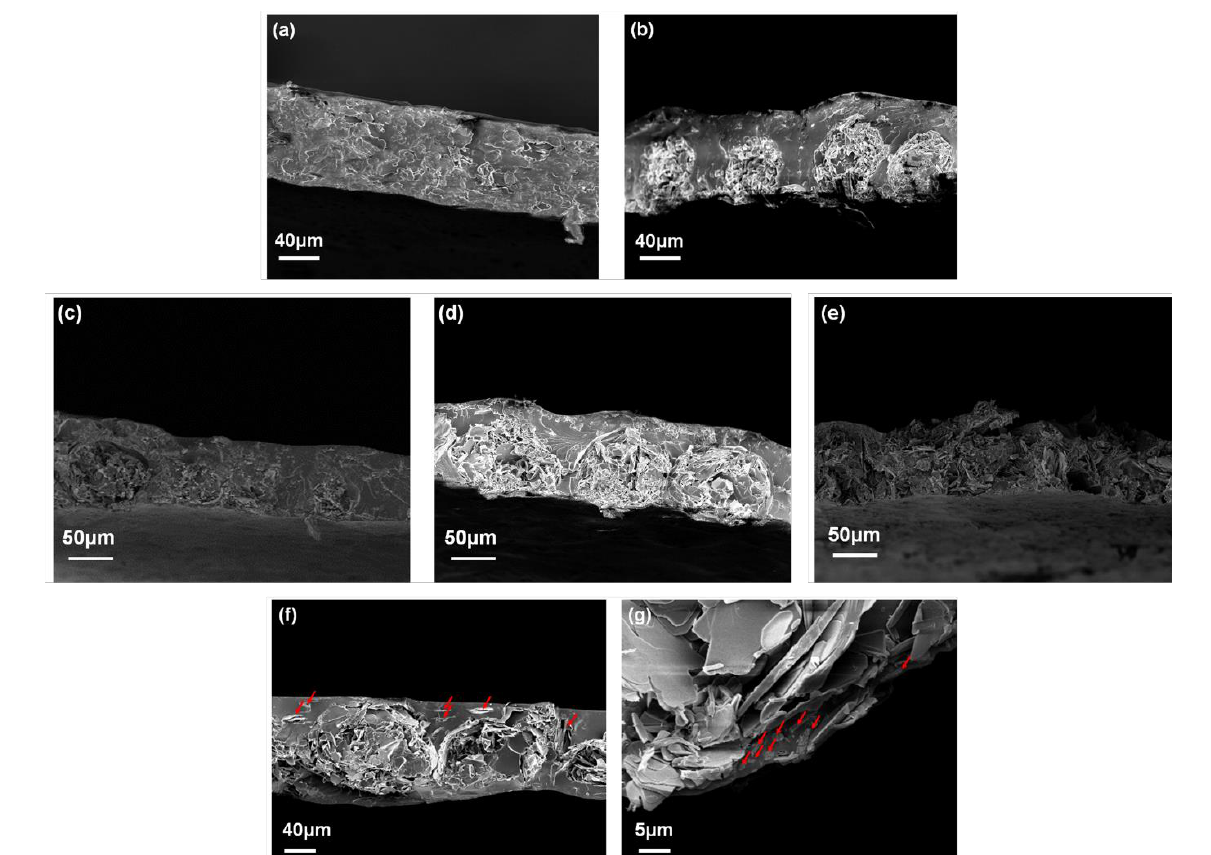
Figure 5. Cross-sectional SEM images of: ( a ) the ABN/PVA; ( b ) the PSZ-ABN/PVA; ( c–e ) the PSZ-ABN/PVA film with ABN loadings of 25 ( c ), 33 ( d ), and 40 wt.% ( e ); ( f ) MXene/PSZ-ABN/PVA film, and ( g ) the MXene-PSZ-ABN/PVA film. MXene is indicated by the red arrows.